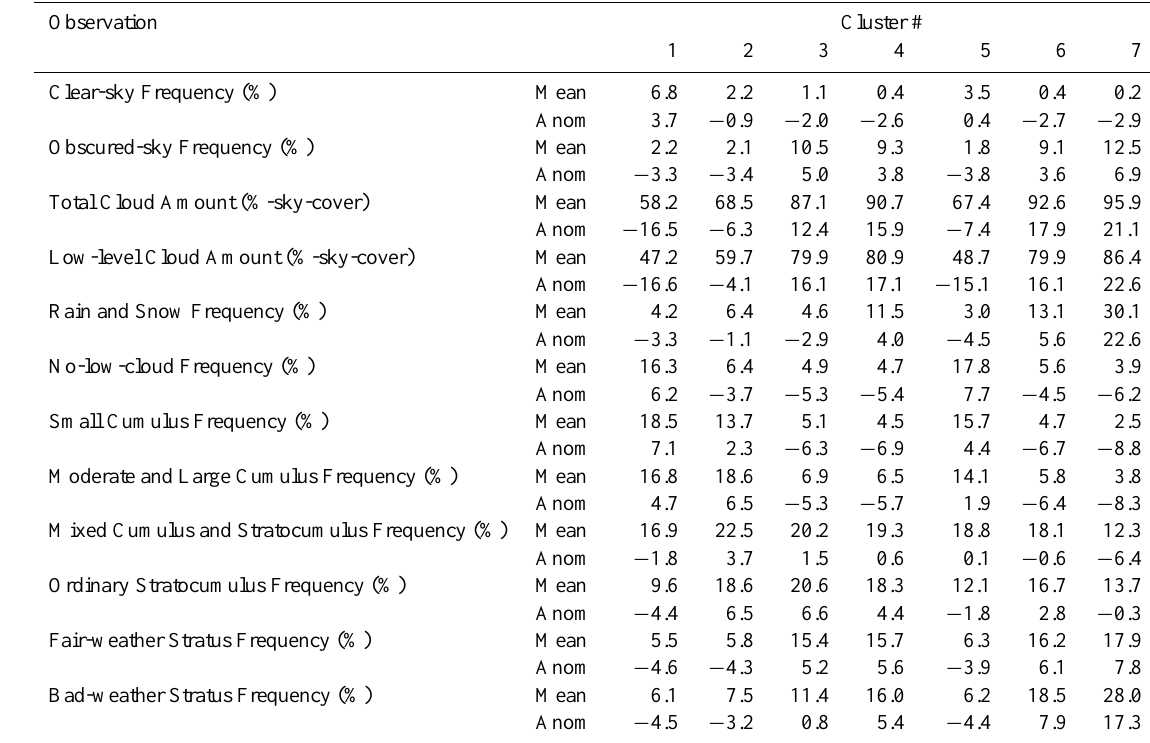
Table 3. Mean surface-reported cloud properties for each cluster (northern hemisphere only), along with anomaly from the average over all